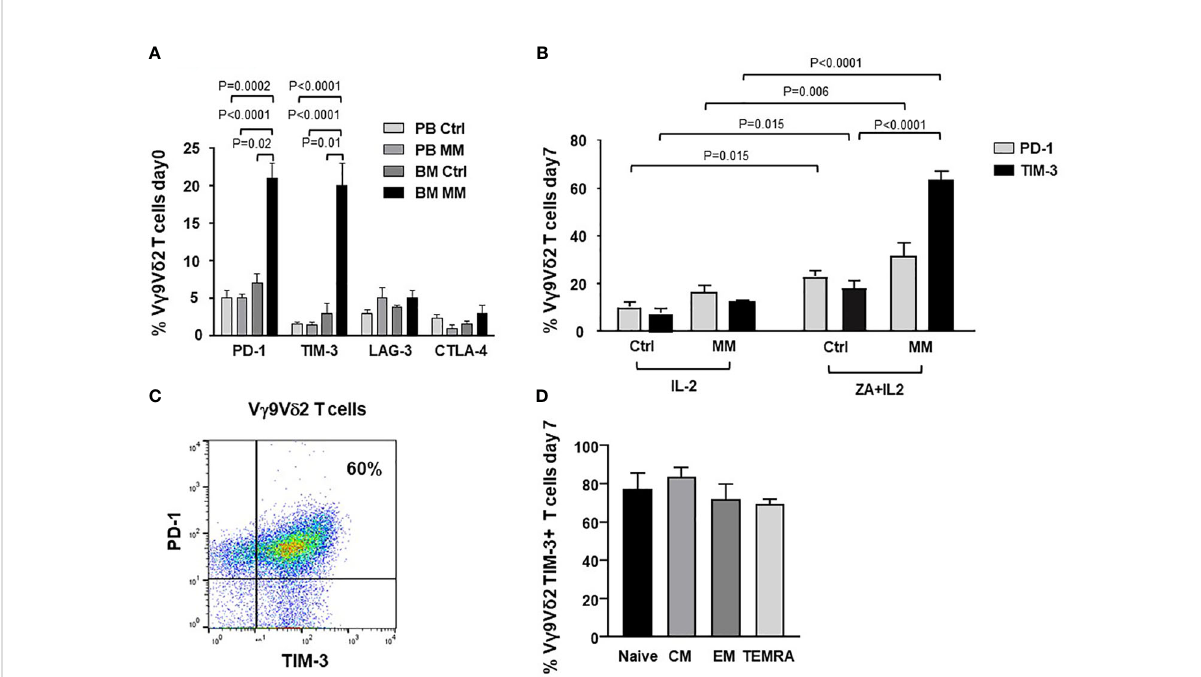
FIGURE 1 ICP expression and subset distribution in resting and ZA-stimulated BM MM V g 9V d 2 T cells. (A) PD-1, TIM-3, LAG-3 and CTLA-4 expression in resting PB and BM V g 9V d 2 T cells from healthy subjects (Ctrl) and MM at diagnosis. Bars represent mean values ± SE from 5 (BM Ctrl) to 30 (BM MM) experiments. (B) PD-1 and TIM-3 expression are signi fi cantly increased after ZA stimulation in MM BM V g 9V d 2 T cells. Bars represent mean values ± SE from 7 (BM Ctrl) to 30 (BM MM) experiments; (C) Cyto fl uorimetric analysis of PD-1 and TIM-3 co-expression in BM MM V g 9V d 2 T cells from one representative MM after ZA stimulation. (D) TIM-3 expression in naive (CD27+ CD45RA+), central memory (CM) (CD27+ CD45RA-), effector memory (EM) (CD27- CD45RA-), and terminally differentiated effector memory (TEMRA) (CD27- CD45RA+) BM MM V g 9V d 2 T cells after ZA stimulation. CM BM MM V g 9V d 2 T cells show the highest TIM-3 expression. Bars represent mean values ± SE of 3